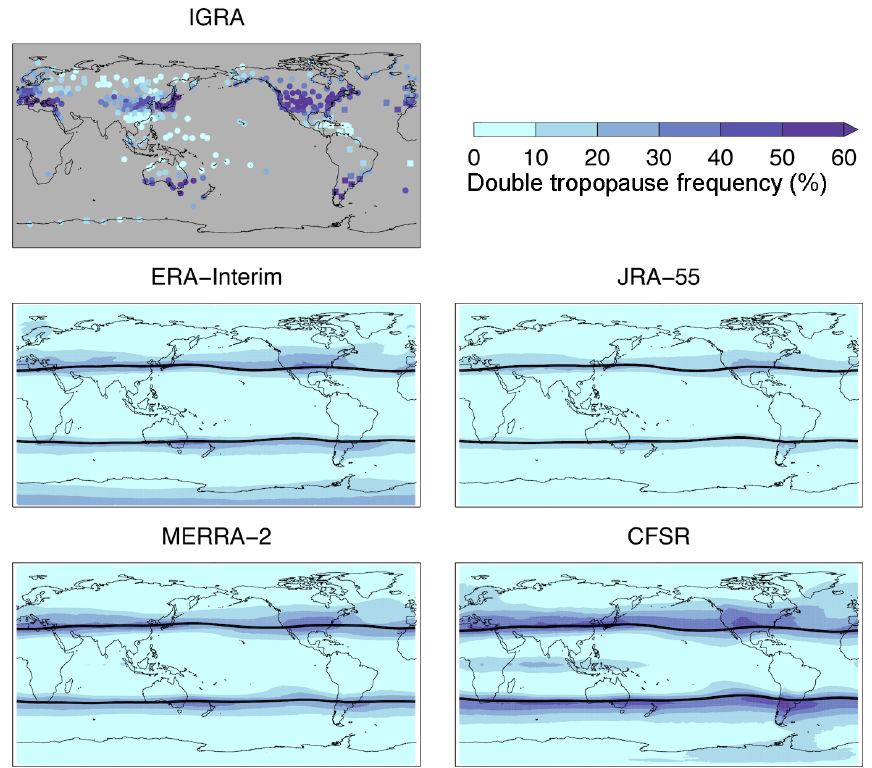
Figure 6. Average double tropopause frequency from 1981 to 2015 for IGRA radiosonde observations and the reanalyses. For IGRA, circles denote 00:00UTC frequencies and squares denote 12:00UTC frequencies. Thick black lines in each reanalysis map show the 35-year mean tropopause break